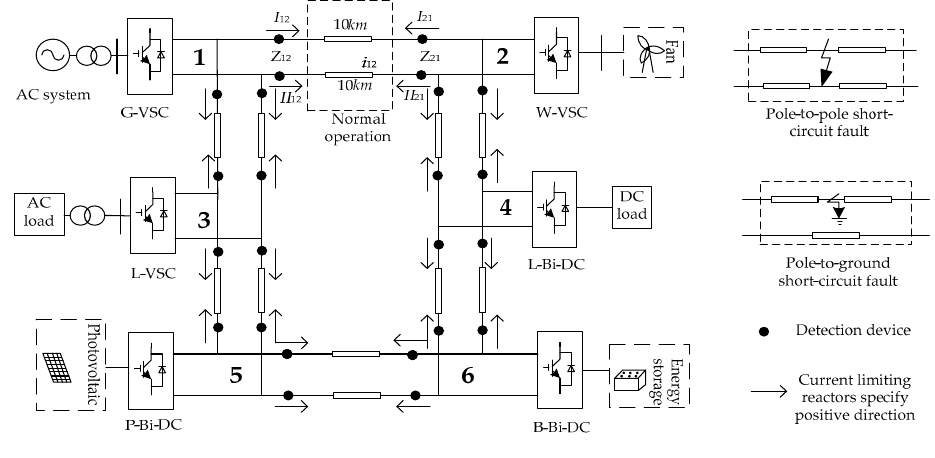
Figure 8. System simulation diagram.